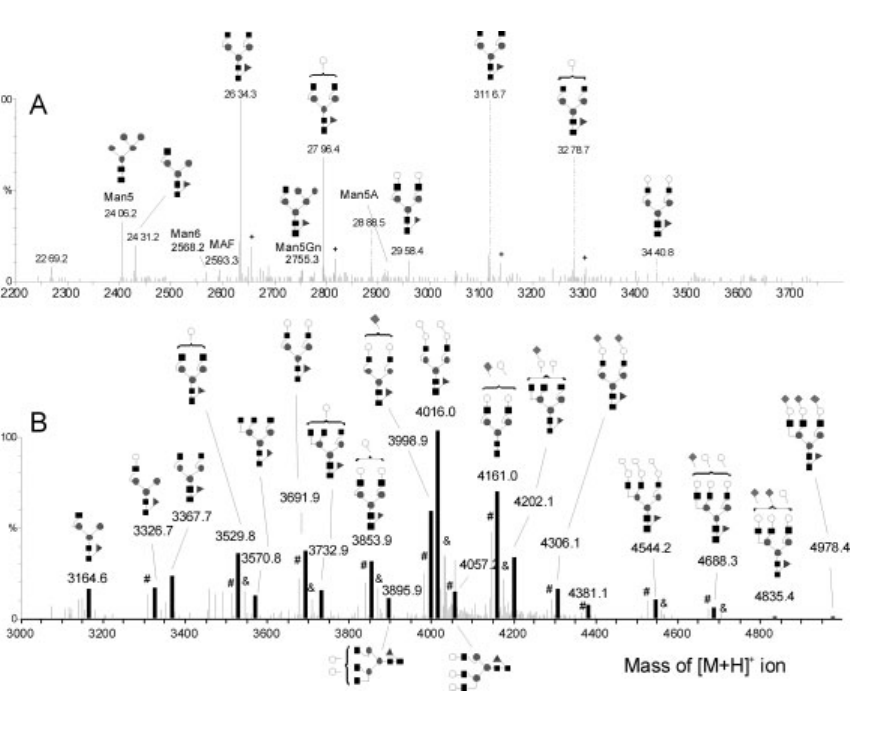
Figure 5. Site-specific glycosyla- tion analysis of Cetuximab (Erbi- tux). (A) Glycopeptides from the constant region. (B) Glycopep- tides from the variable region of the heavy chain displaying a drastically different glycan pro- file. Note the occurrence of trian- tennary glycans, the a 1,3-galac- tosylatedandthe a 2,3-sialylation. All sialic acids were N -glyco- lylneuraminic